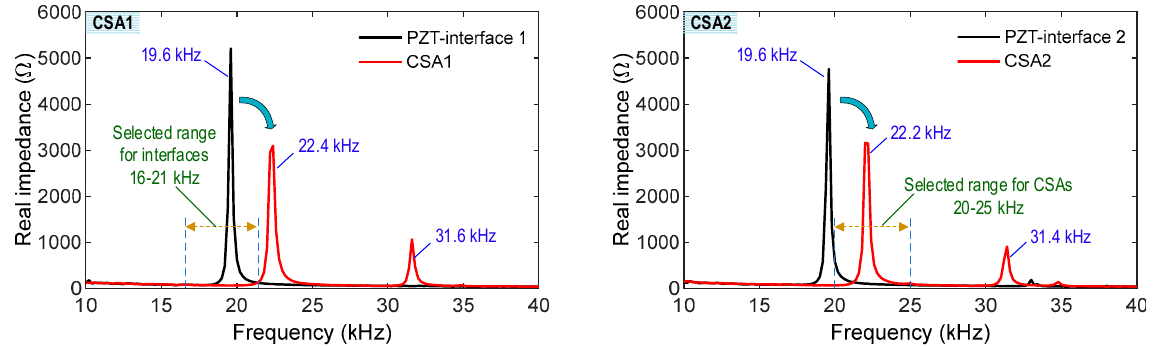
Figure 13. Impedance signals of CSAs during fabrications.